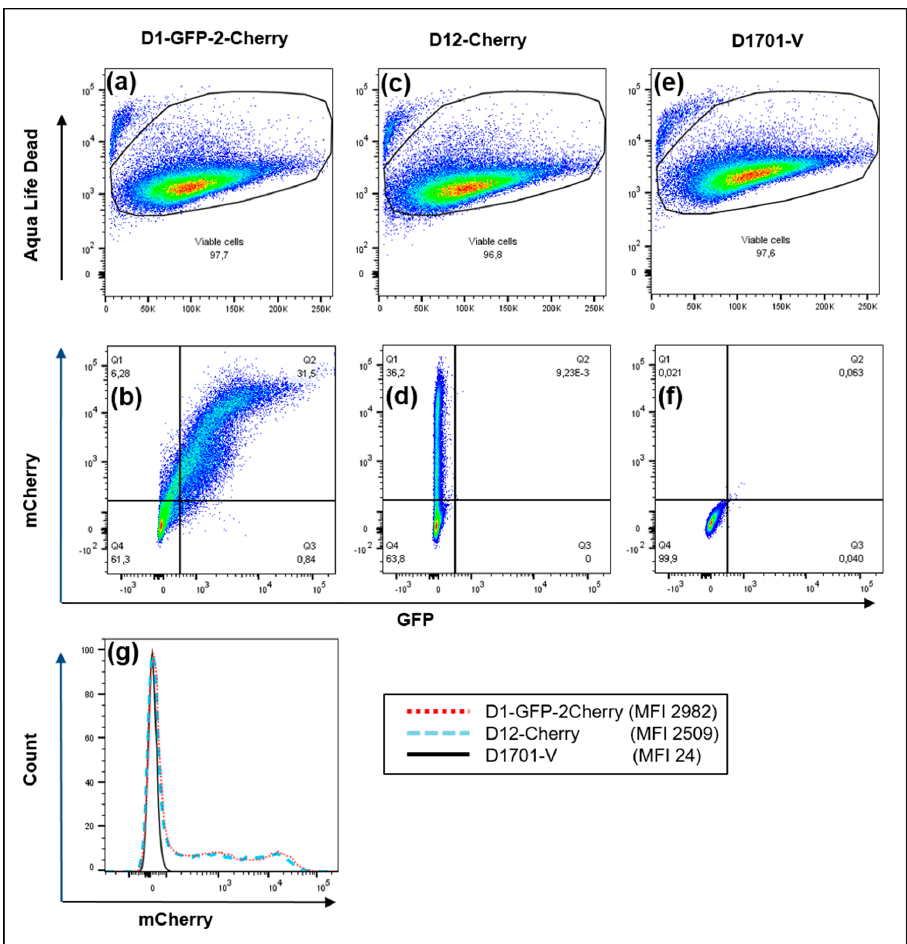
Figure 5. Characterization of ORFV recombinant D1701-V-D1-GFP-2-Cherry. ( A ) Insertion site- and insert-specific PCR. ( Aa ) Illustrates location of primers in plasmid pD1-AcGFP-2-mCherry, which are used for locus D-specific PCR (Del2-F and DEl2-R2), for mCherry- (Ch-F and Ch-R) and for AcGFP-specific PCR (GFP-F and GFP-R); eP1 and eP2 denote the early promoters. ( Ab ) The Del2-FR2 PCR with DNA from parental D1701-V infected Vero cells results in 0.39 kbp amplicon (lanes 1 and 2) due to the lack of gene insertion. After infection with the recombinant D1-GFP-2-Cherry the specific 2.28 kbp amplicon (lane 3) was obtained and with recombinant D12-Cherry the specific 1.43 kbp PCR product was amplified (lane 4). No specific amplification was found with DNA from non-infected cells (lane 5) and H2O as another control (lane 6). Lane M shows separation of size markers (1 kbp ladder, NEN Biolabs). ( Ac ) Correct insertion of AcGFP and mCherry gene in DNA of recombinant D1-GFP-2-Cherry was proven by PCR using the following primer pair combinations: GFP-F and Ch-R (lane 1, 1.57 kbp amplicon), Del2-F and GFP-R (lane 2, 0.98 kbp amplicon), GFP-F and Del2-R2 (lane 3, 1.88 kbp amplicon), Ch-F and Del-2R2 (lane 4, 0.90 kbp amplicon). ( B ) Confocal microscopy Vero cells were infected overnight with the recombinant D1-GFP-2-Cherry (moi 1.0), fixed and inspected for green fluorescence of AcGFP ( a ), red fluorescence of mCherry ( b ) and both merged (yellow) in combination with phase contrast microscopy ( c ). Microscopic magnification 40 × . ( C ) Flow cytometry Viability (Aqua Life Dead) and fluorescent protein expression in Vero cells 24 hours after infection (moi of 2.0) with ORFV recombinant D1-GFP-2-Cherry ( a,b ), with ORFV recombinant D12-Cherry ( c,d ) and as a negative control with D1701-V ( e,f ). In ( b ), ( d ) and ( f ) the X -axis shows the number of GFP (FITC) -positive cells and the Y -axis the number of mCherry (PE)-positive cells. The overlay of the histograms of ( b ), ( d ) and ( f ) is plotted in ( g ) for direct comparison of mCherry-positive cells. The mean mCherry fluorescence intensity (MFI) is given in the